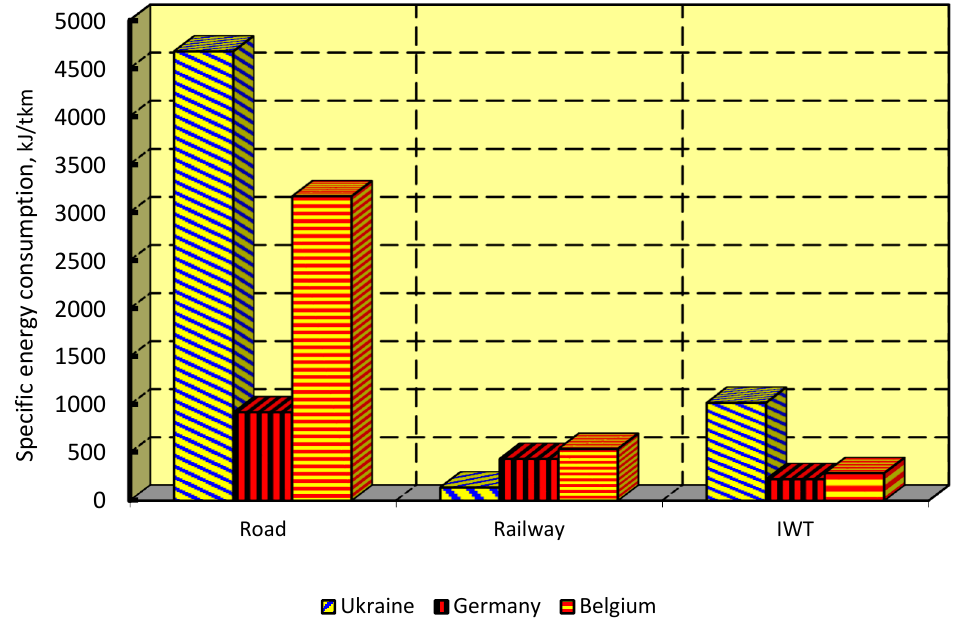
Figure 6. Specific energy consumption.